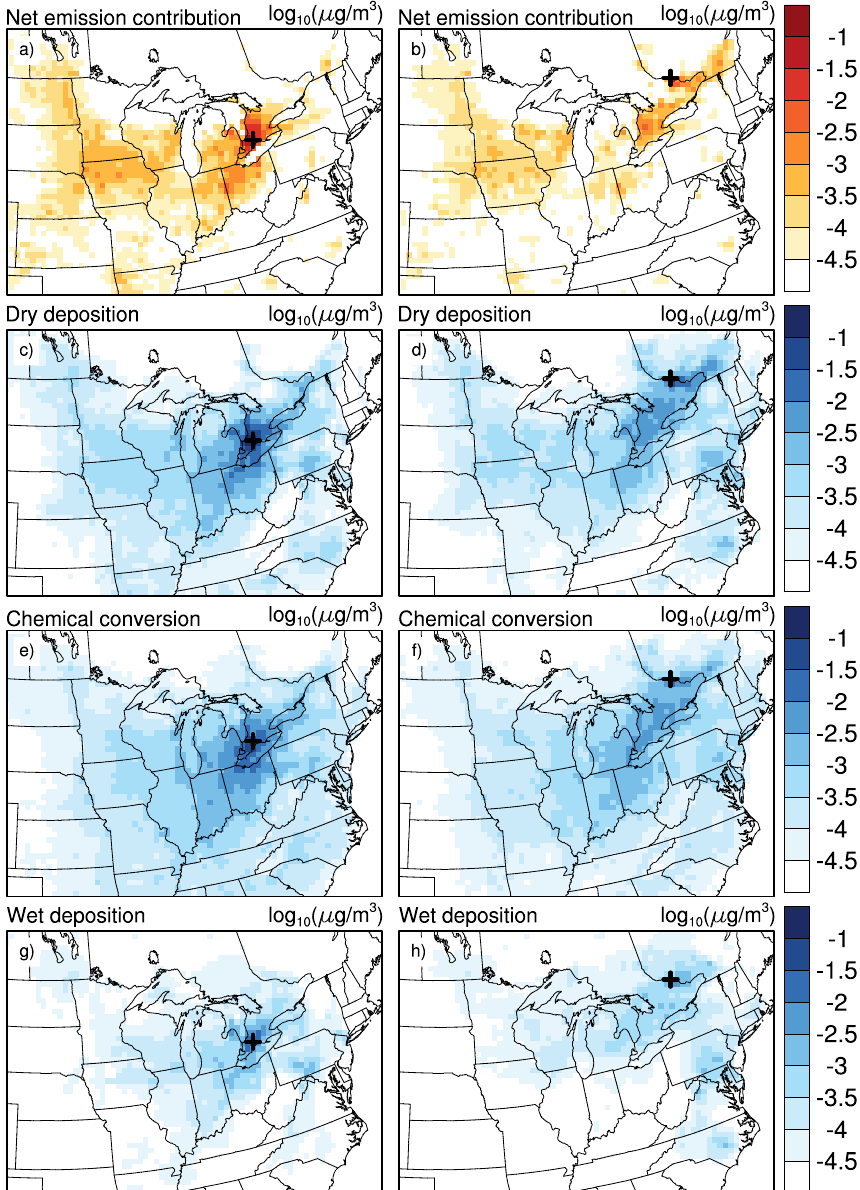
Fig. 7. Modeled upstream influences on simulated NH 3 concentrations from net emission contribution ( a and b ); dry deposition ( c and d ); chemical conversion ( e and f ); and wet deposition ( g and h ) over 6 months at two sites: Longwoods (left) and Chalk River (right). Each panel shows an average over the entire simulation period. Red color scale represents positive contributions (source) whereas blue scale represents negative contributions (loss). Site locations are indicated by